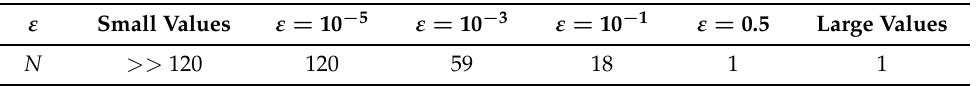
Table 3. The number of iterations for different values of ε using the SE-Sinc integration rule for solving the RO system based on the FPA.